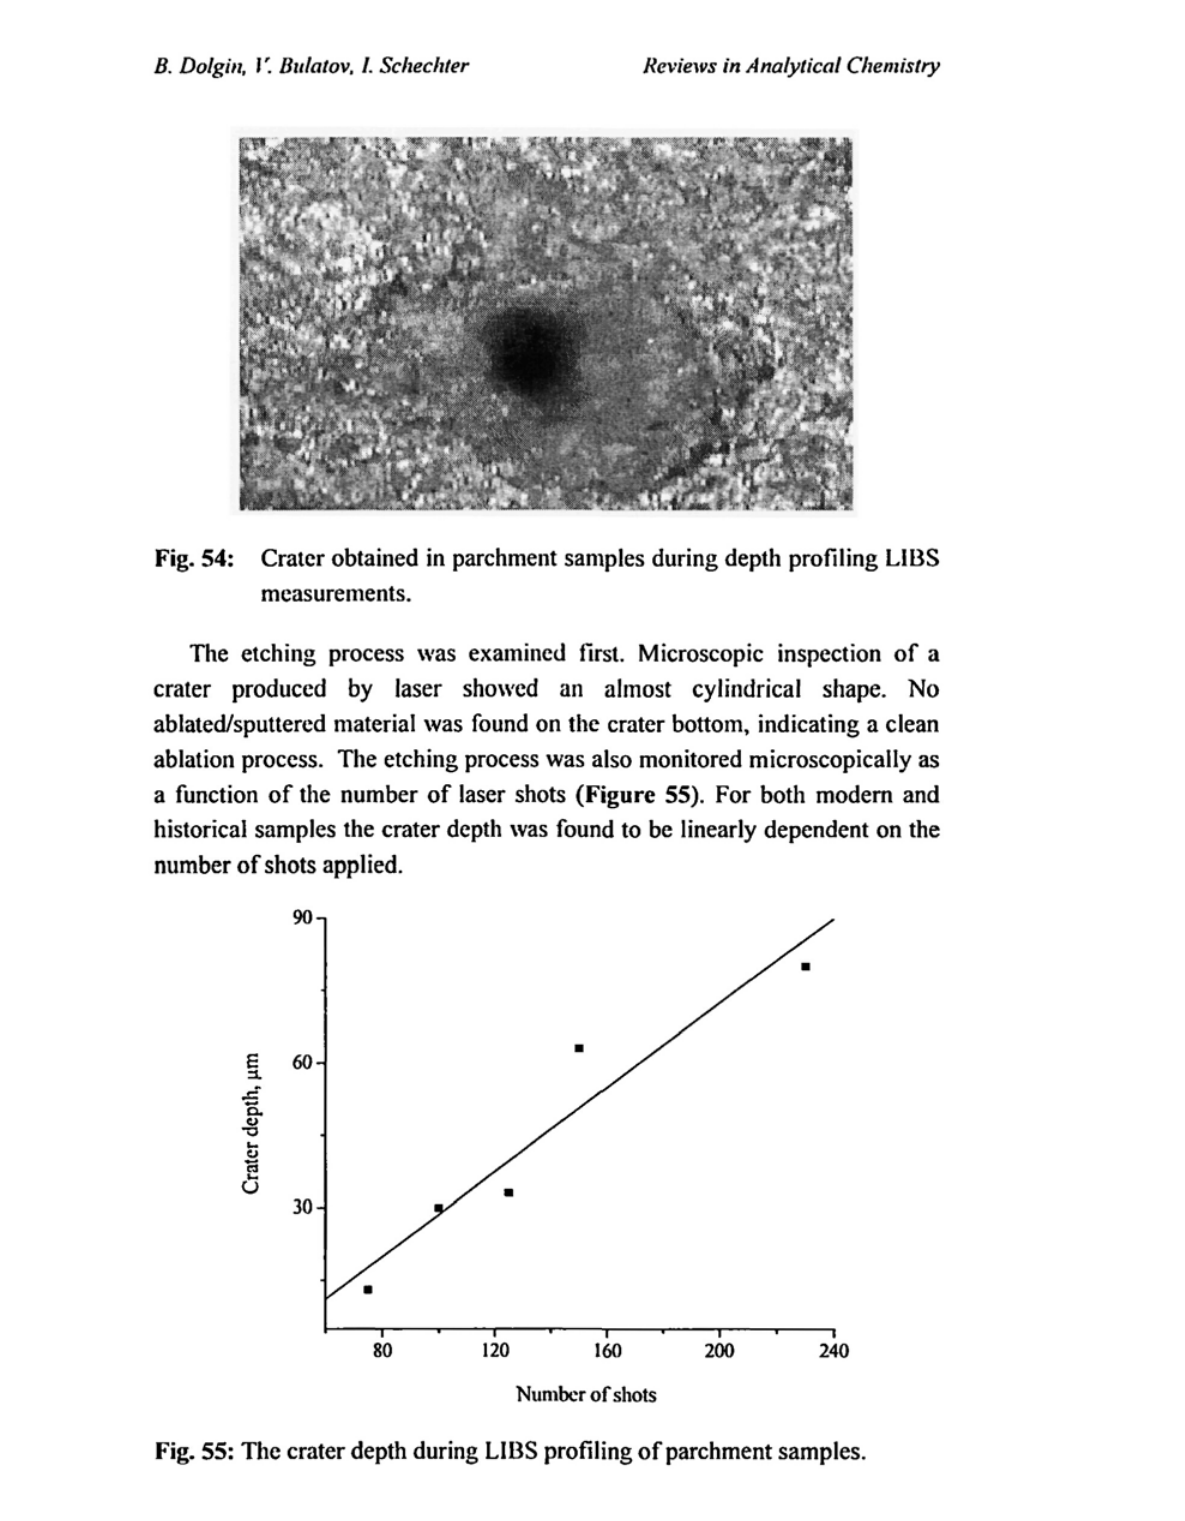
Fig. 55: The crater depth during LIBS profiling of parchment